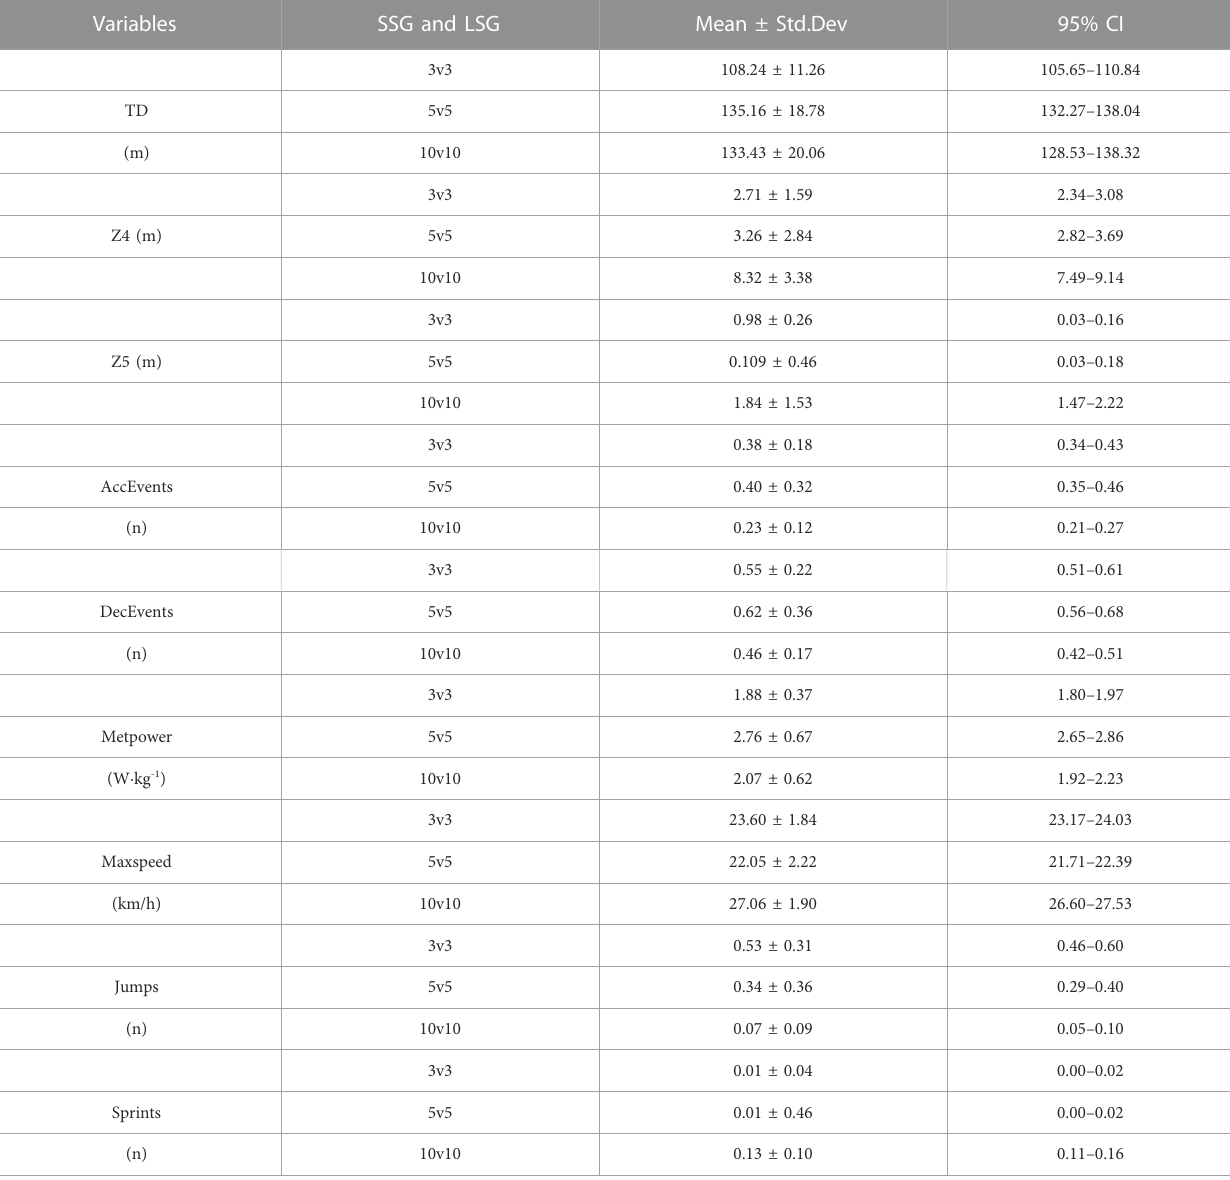
TABLE 2 Descriptive statistics of variables based on 1 min of play in three different game